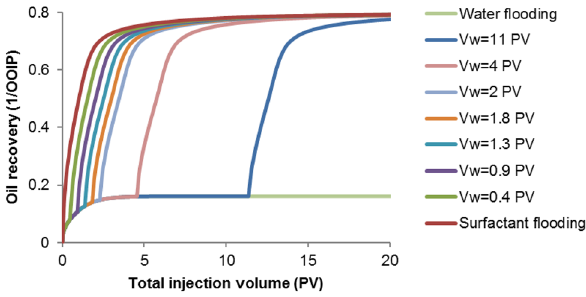
Fig. 18 Oil recovery of surfactant flooding following a pre-water flooding in the base case (with surfactant diffusion)